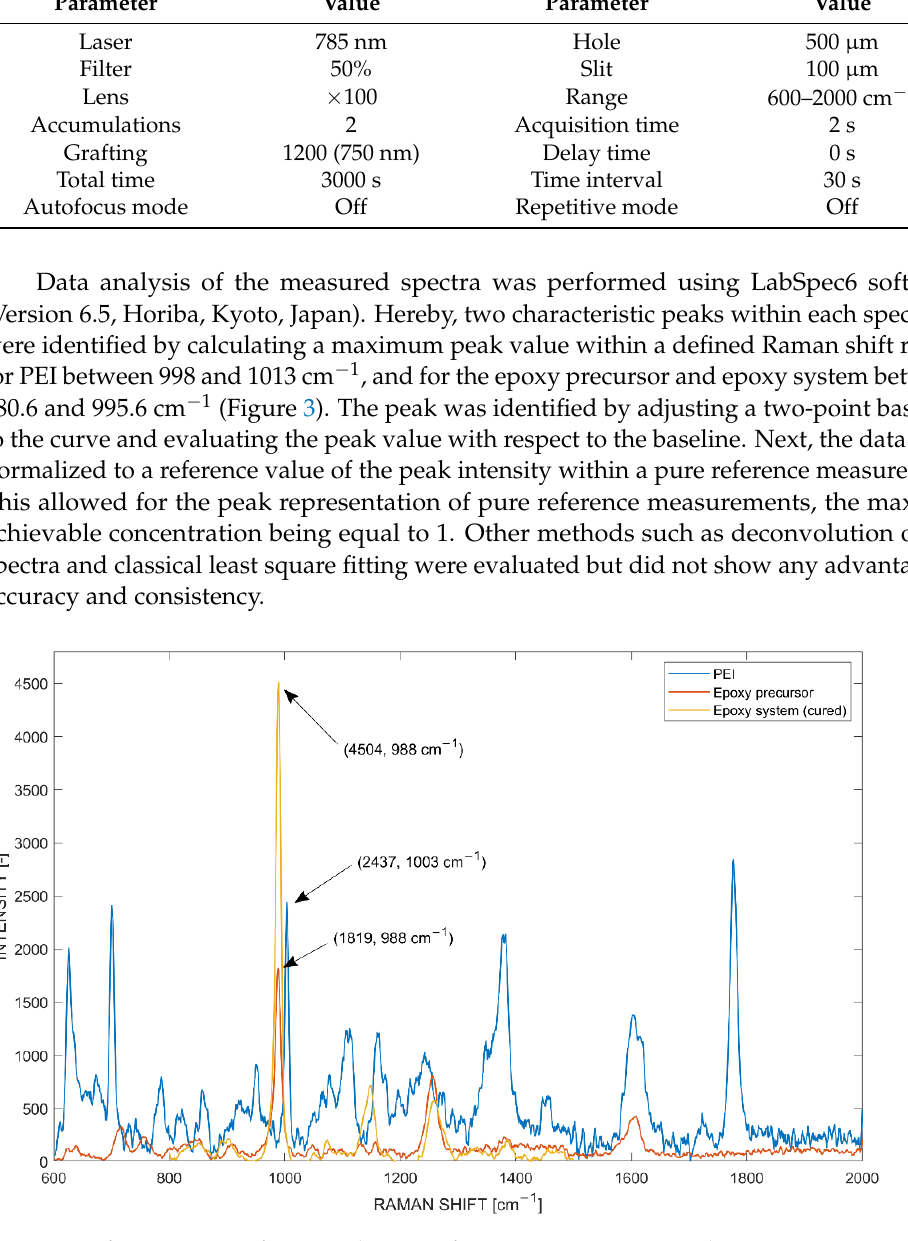
Figure 3. Reference spectra for normalization of PEI, epoxy precursor and epoxy system